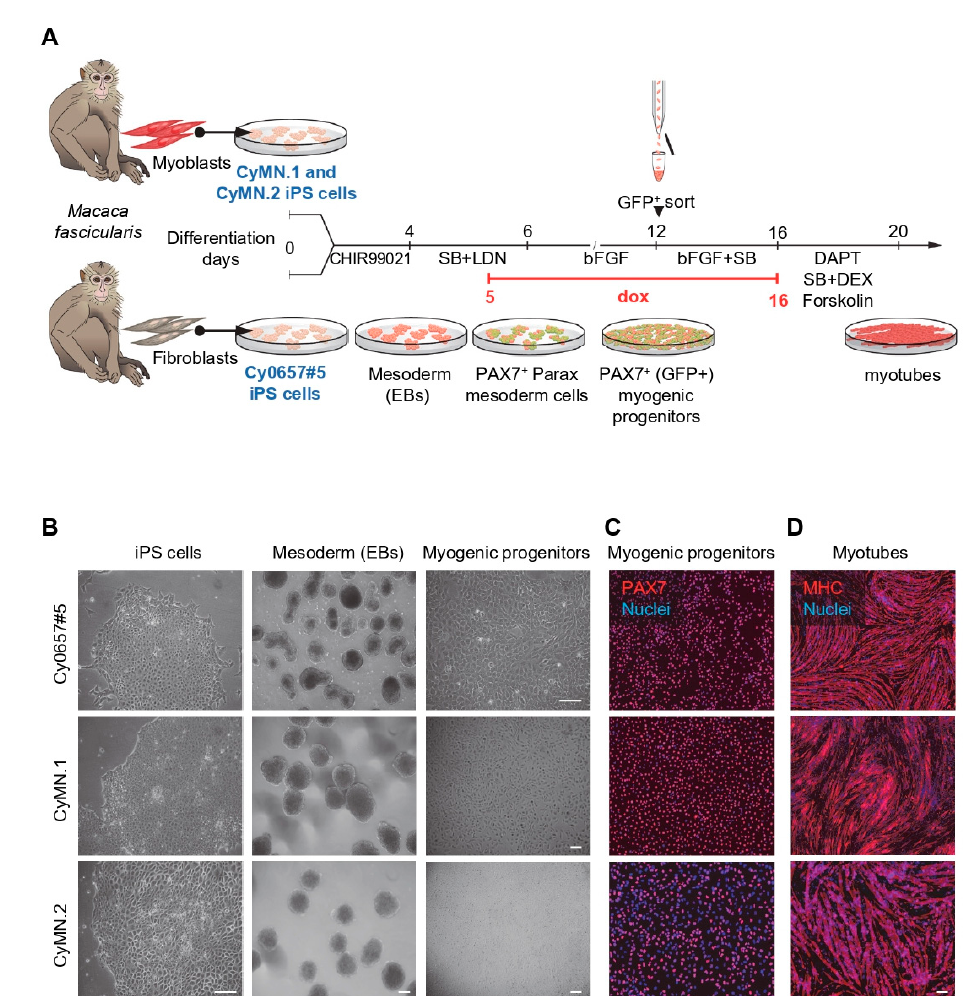
Figure 1. Generation of NHP iPS cells and their in vitro myogenic differentiation: ( A ) Outline of experimental design. PAX7 expression was induced on day 5 of di ff erentiation by adding dox to the medium; ( B ) representative images show the morphology of NHP iPAX7 iPS cell colonies ( left ), day-4 embryoid bodies (EBs; center ), and expanded PAX7+ myogenic progenitors ( right ); ( C ) im- munostaining for PAX7 expression in GFP+-sorted myogenic progenitors from day-12 cultures. PAX7 is shown in red and DAPI stains nuclei in blue; ( D ) representative images show terminal dif- ferentiation of PAX7 myogenic progenitors into myotubes. Staining for MHC is shown in red and nuclei in blue. Scale bars, 100 µm.